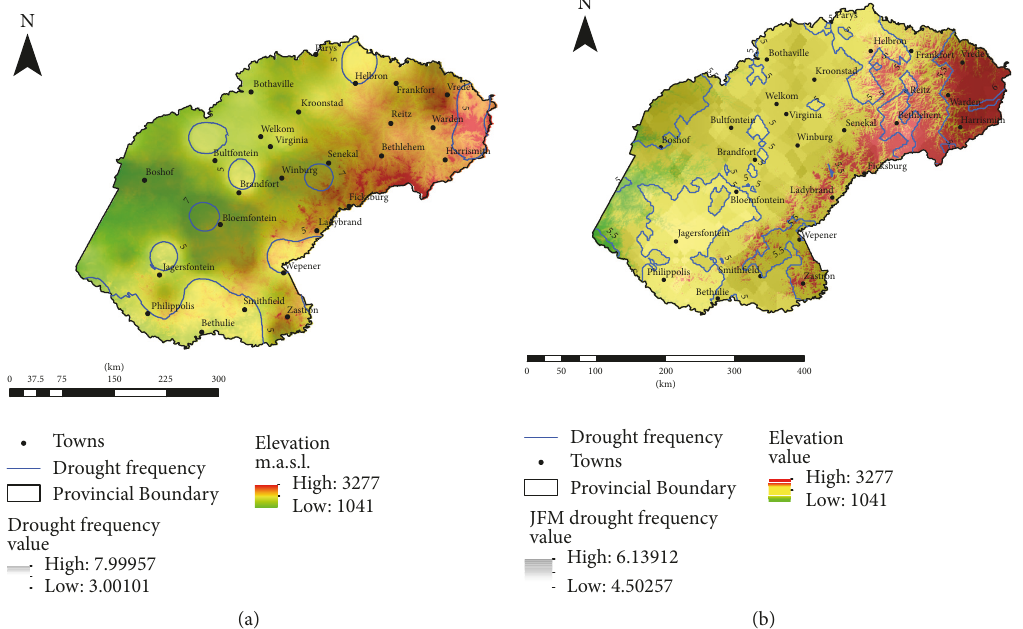
Figure 6: Frequency of drought years (SPI ≤ − 1.282) for (a) OND and (b) JFM for the period 1960–2013.